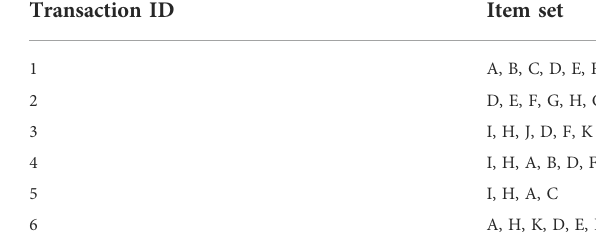
TABLE 3 Example table.